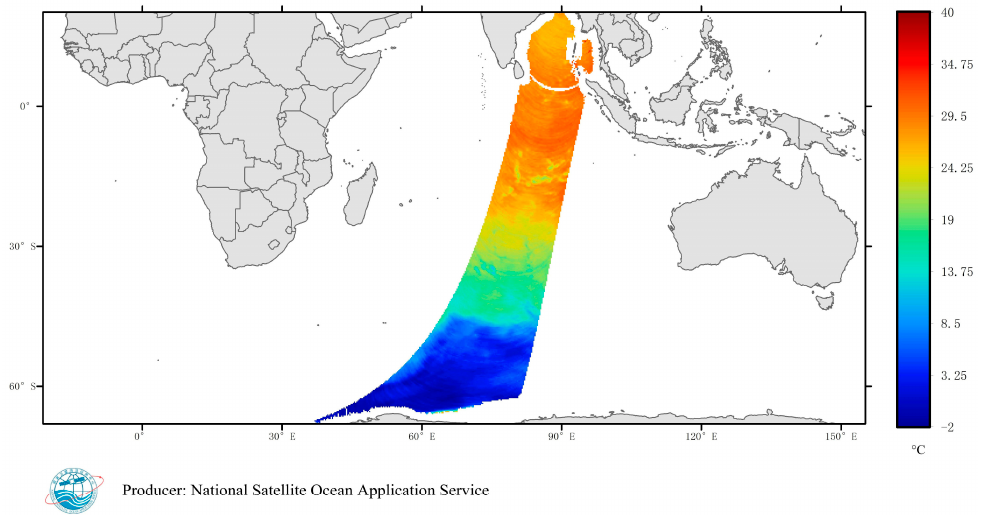
Figure 6. A Sea Surface Temperature thematic map of a single HY-2A swath for 25 March 2015 derived from the HY-2A CAPF. The sample points of sea surface temperature are mapped to a 0.25-degree grid. The colors correspond to the temperature scale.